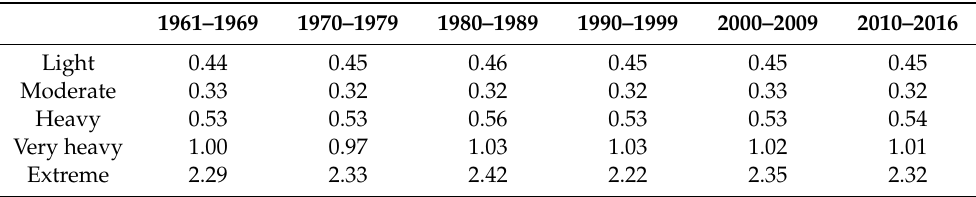
Table 2. Interannual variation of CV of precipitation.